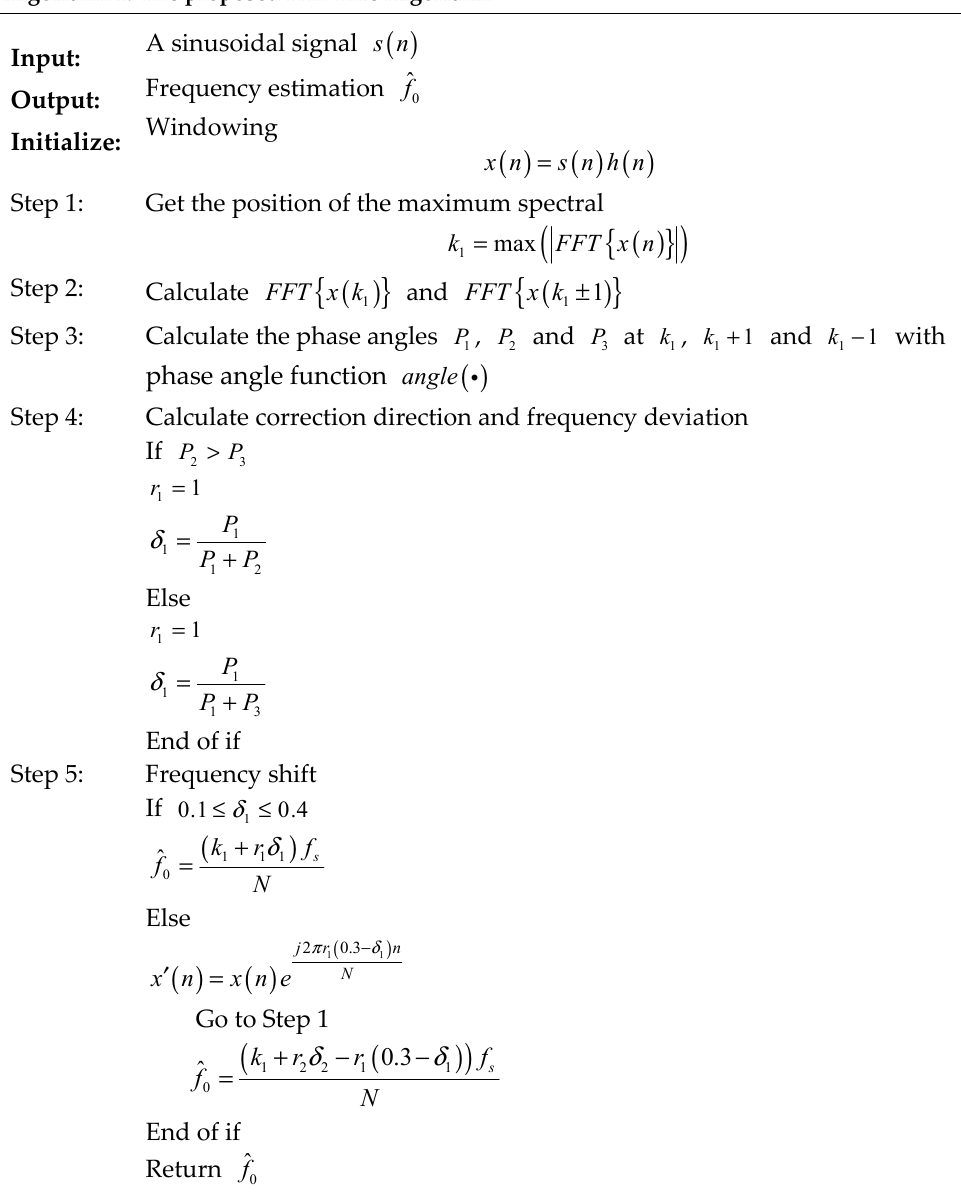
Algorithm 1: The proposed PAI–Rife Algorithm